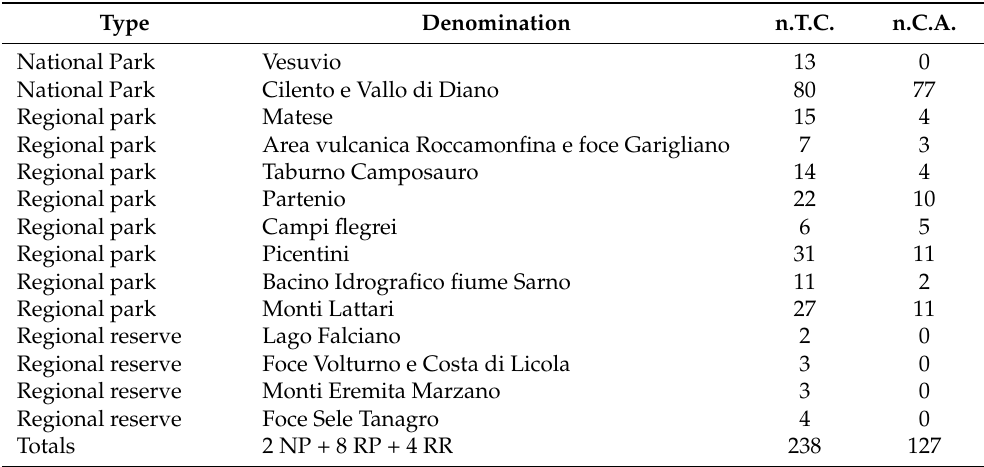
Table 7. Protected Natural Areas of the Campania Region with municipal territories (n.T.C.)